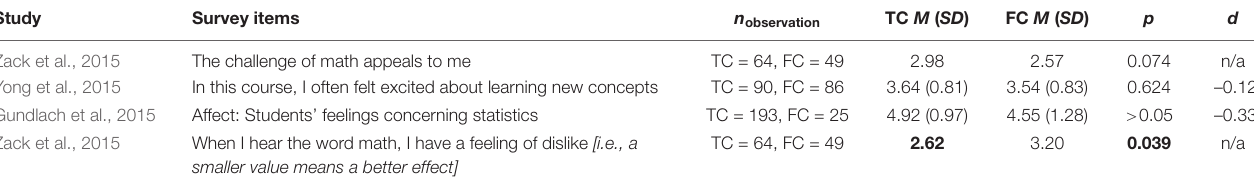
TABLE 5 | Survey results: Feelings by effect size.